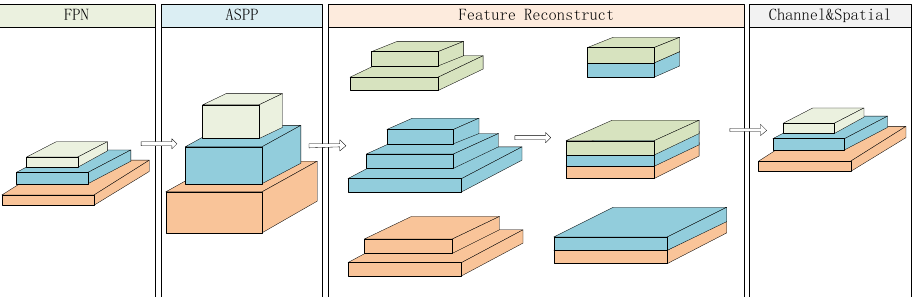
Figure 1. The entire pipeline consists of multiple receptive fields for the feature extractor, feature constructor module, and attention module MLCS.